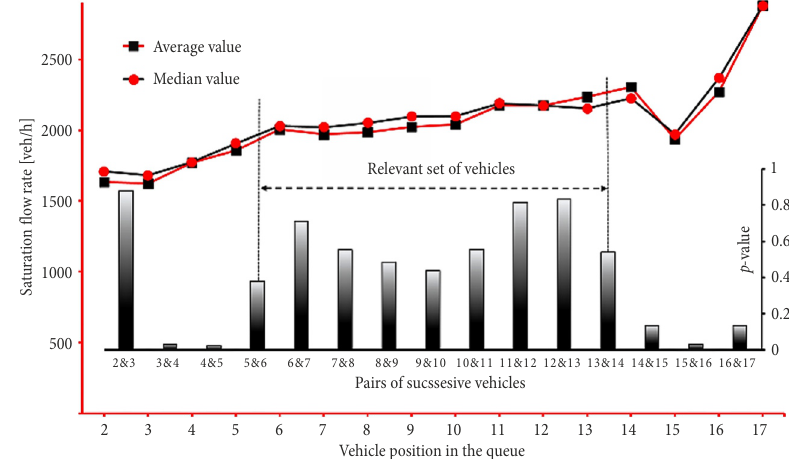
Fig. 2. Procedure of determining the relevant set of